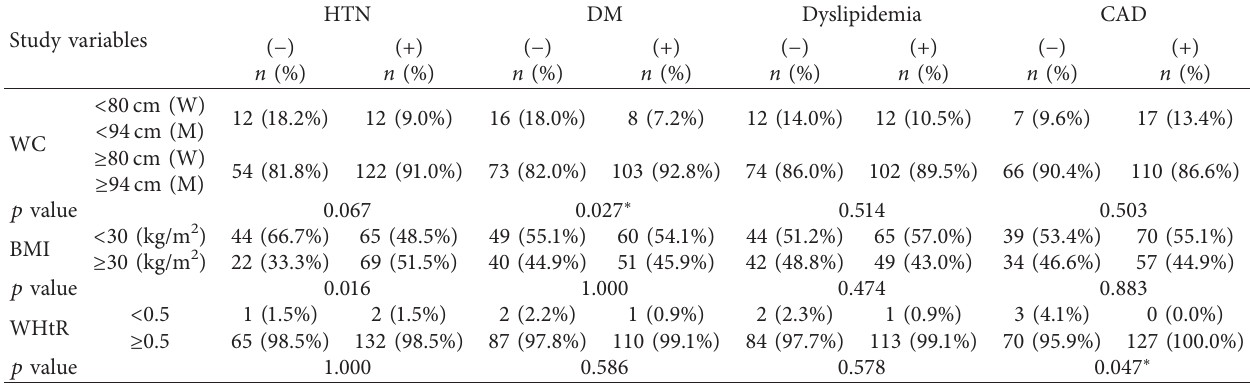
Table 3: Positive and negative results as per risk factors and CAD.